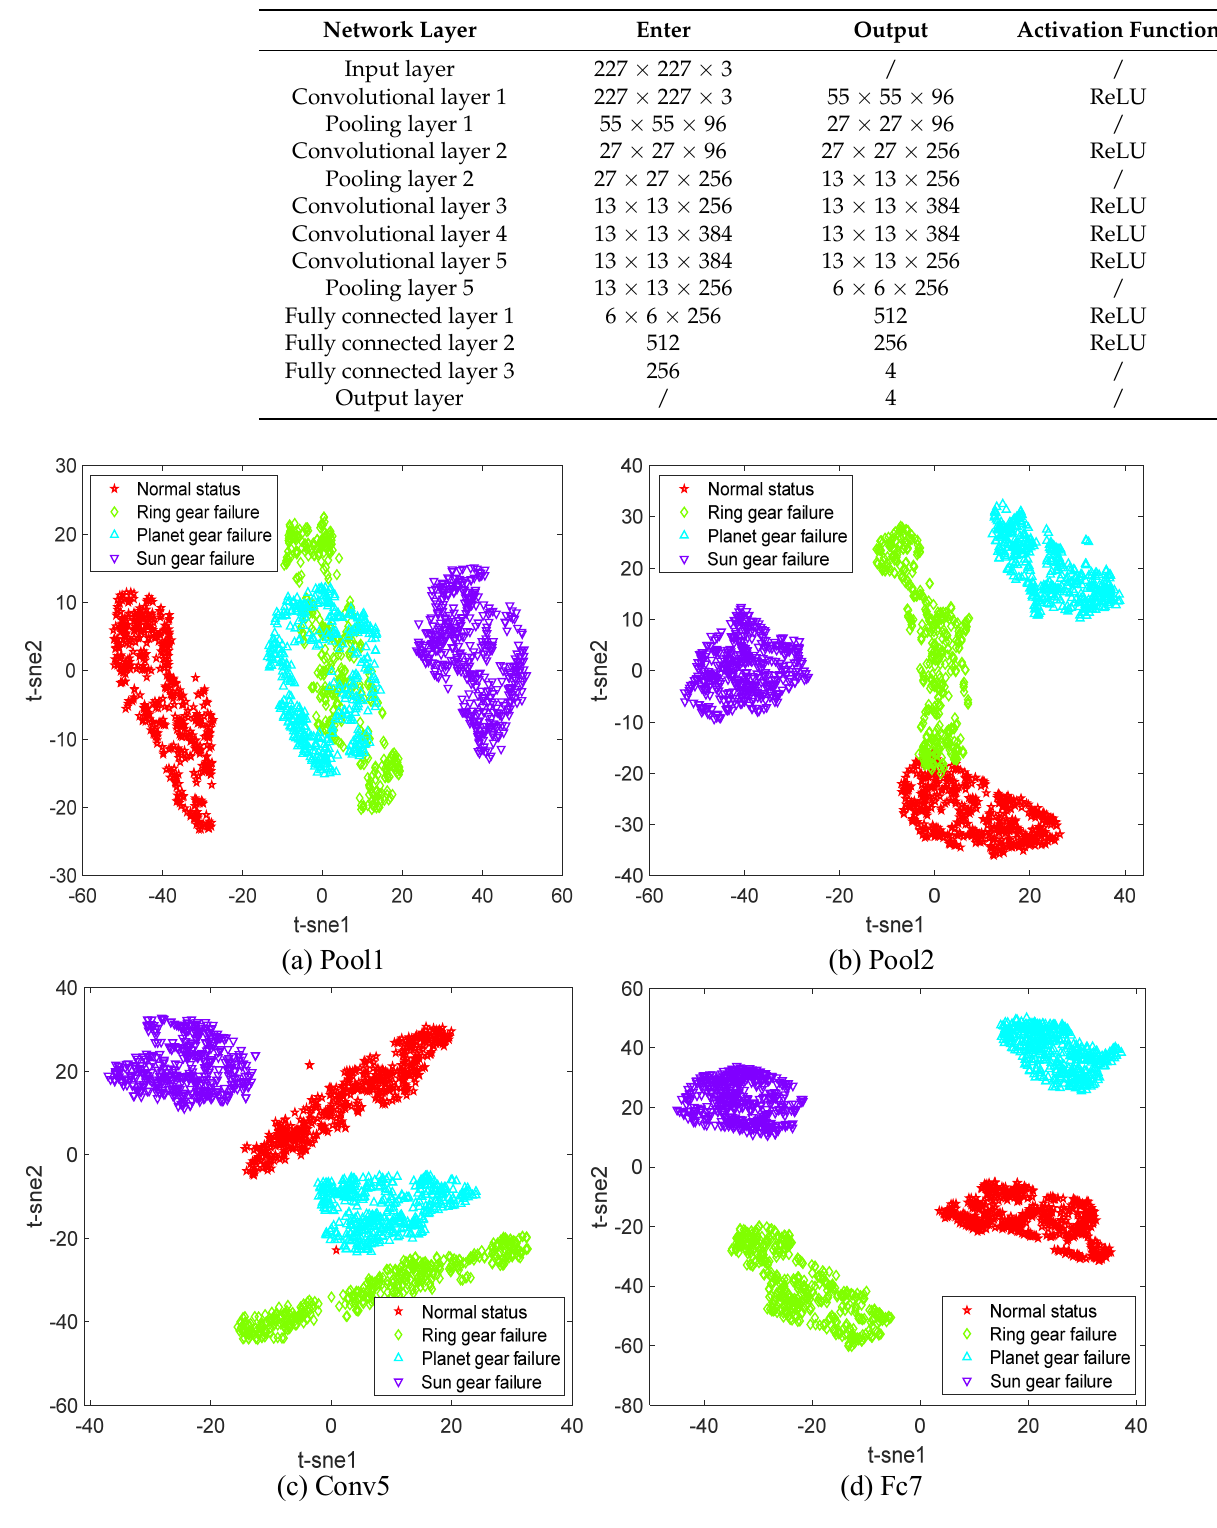
Figure 10. The t-SNE visual analysis of the AlexNet network feature extraction process: ( a ) maximum pooling layer 1 feature; ( b ) maximum pooling layer 2 feature; ( c ) Conv5 layer feature; ( d ) Fc7 layer feature.